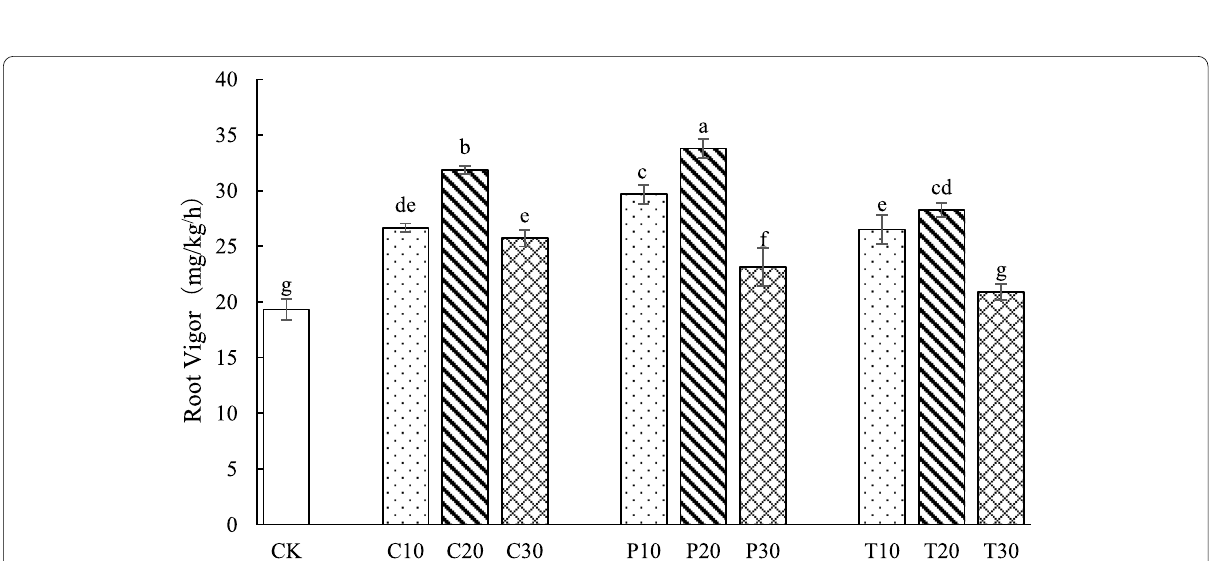
Fig. 7 Effect of different vegetable residues on the root vigor of cucumber after 60